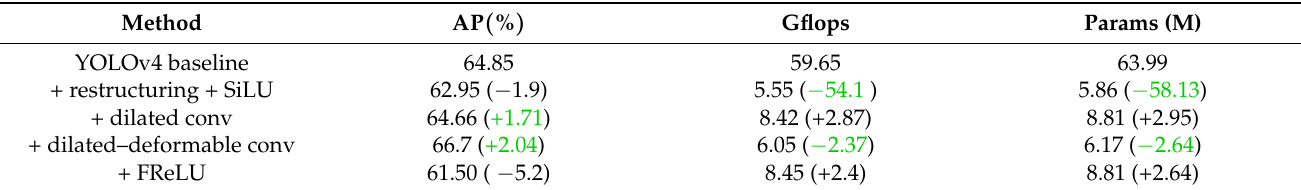
Table 3. Roadmap of YOLOG, in terms of AP (%), on the garbage data validation set. All models were tested at 416 × 416